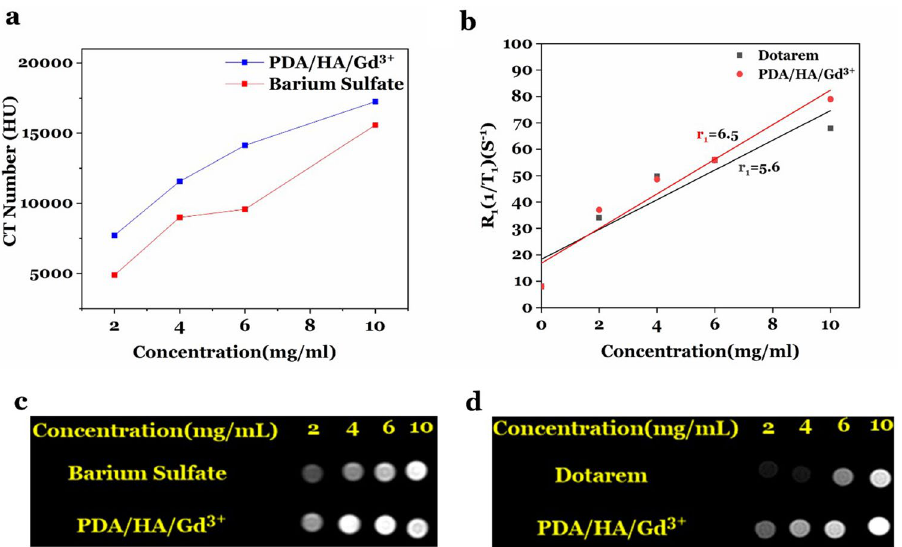
Figure 7. MRI, CT, and T1 weighted MRI plots. ( a and c ) The CT number plot and the signal rate of PDA/ HA/Gd 3+ NPs at different concentrations (2, 4, 6, and 10 mg/ml) were compared with barium sulfate (as a commercial CT contrast-positive control), respectively. ( b and d ) T1 weighted MRI plot and the signal rate of PDA/HA/Gd 3+ NPs at different concentrations (2, 4, 6, and 10 mg/ml) in comparison to Dotarem (as a commercial MRI contrast-positive